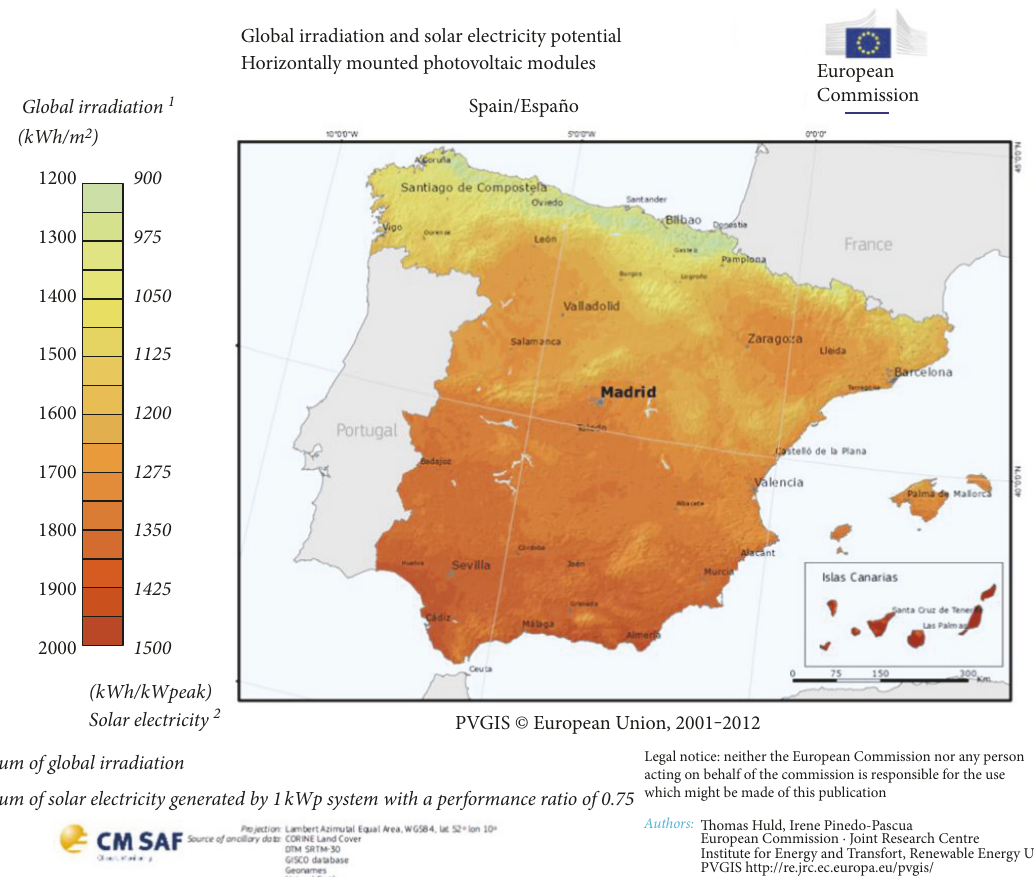
Figure 3: Global irradiation and solar electricity potential on horizontally mounted PV modules in Spain